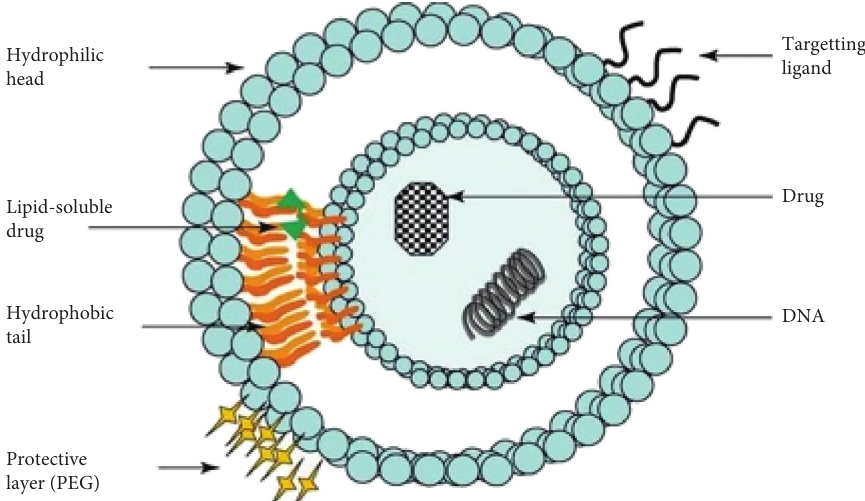
Figure 2: Diagram illustrating a liposome entrapping both hydrophilic and hydrophobic drugs in the aqueous core and lipid bilayer, respectively. The surface of the liposome allows for the addition of targeting ligands and a polyethylene glycol coating for active and passive targeting, respectively [8].